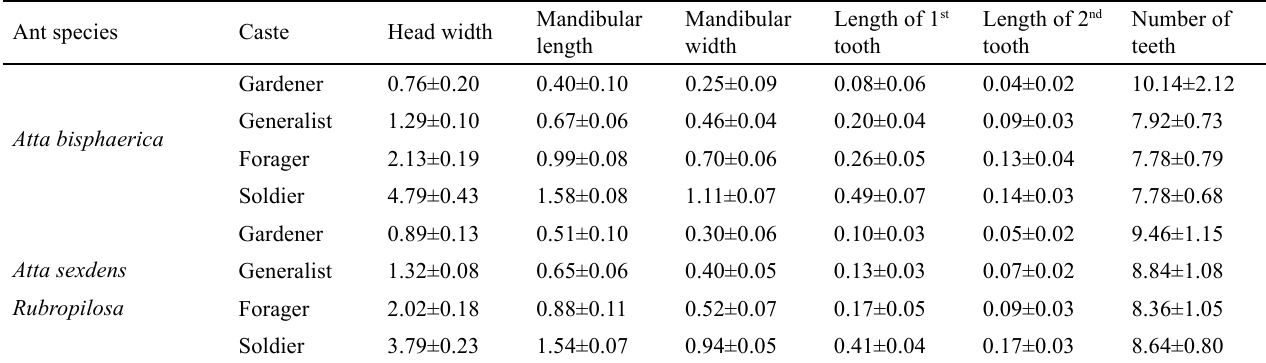
Table 1 . Morphometric measures (mean and standard deviation) (mm) of the mandibles and teeth of Atta bisphaerica and Atta sexdens rubropilosa .